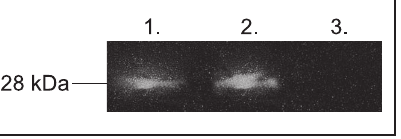
Figure 3. mCherry protein was produced in schistosomula transfected with plasmids expressing mCherry regulated by the SV40 promoter. Total protein was extracted from schistosomula expressing mCherry regulated by the SV40 promoter (Lane 1) and assayed by Western blot analysis using a primary antibody targeting the mCherry protein. The mCherry expression regulated by the CMV promoter was used as a positive control (Lane 2) and total protein from untransfected schistosomula was used as a negative control (Lane 3).